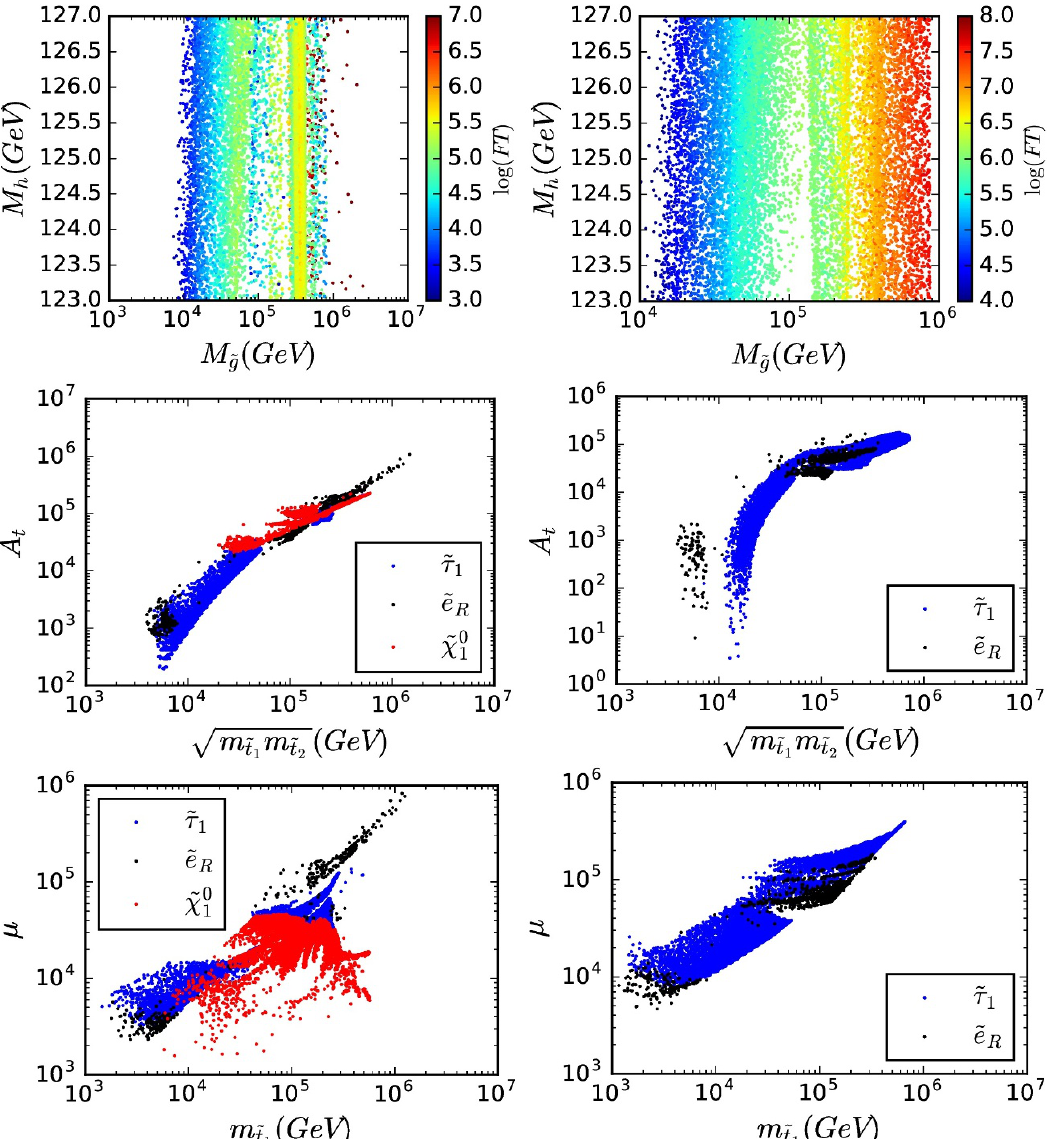
Figure 5 . Allowed regions for various LOSP with a = 3 (left panel) and a = 2 (right panel) in scenario II. All points satisfy the constraints from (I) to (III). In the upper panels, the BGFT measure is used to parameterize the level of